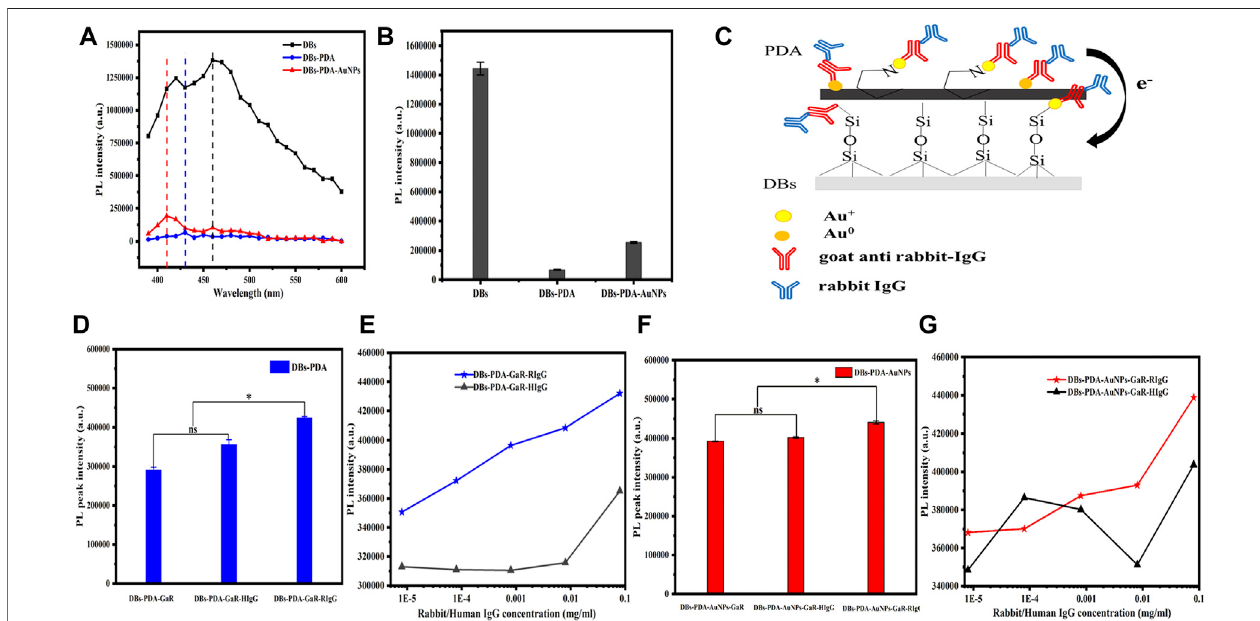
FIGURE4|(A) PLspectraofDBs,DBs-PDA,andDBs-PDA-AuNPs. (B) ComparisonofPLpeakintensityofDBs,DBs-PDA,andDBs-PDA-AuNPs. (C) Schemaof functionalized DBs-PDA-AuNPs with antibody GaR and complimentary antigen RIgG. (D) Comparison of the PL peak intensity of DBs-PDA-GaR (DBs-PDA-antibody), DBs-PDA-GaR with RIgG (DBs-PDA-antibody-comp. antigen), and DBs-PDA-GaR with HIgG (DBs-PDA-antibody-non-comp. antigen). (E) Comparison of PL peak intensity variation of DBs-PDA-GaR versus RIgG and HIgG (from 8 × 10 − 6 to 8 × 10 − 2 mg/ml), respectively. ns represents no signi fi cant difference, p > 0.05* represents a signi fi cant difference, and p < 0.05. (F) Comparison of PL peak intensity of DBs-PDA-AuNPs-GaR, DBs-PDA-AuNPs-GaR with RIgG, and DBs-PDA- AuNPs-GaR with HIgG. (G) Comparison of PL peak intensity variation of DBs-PDA-AuNPs-GaR versus RIgG and HIgG (from 8 × 10 − 6 to 8 × 10 − 2 mg/ml), respectively. Excitation wavelength was 360